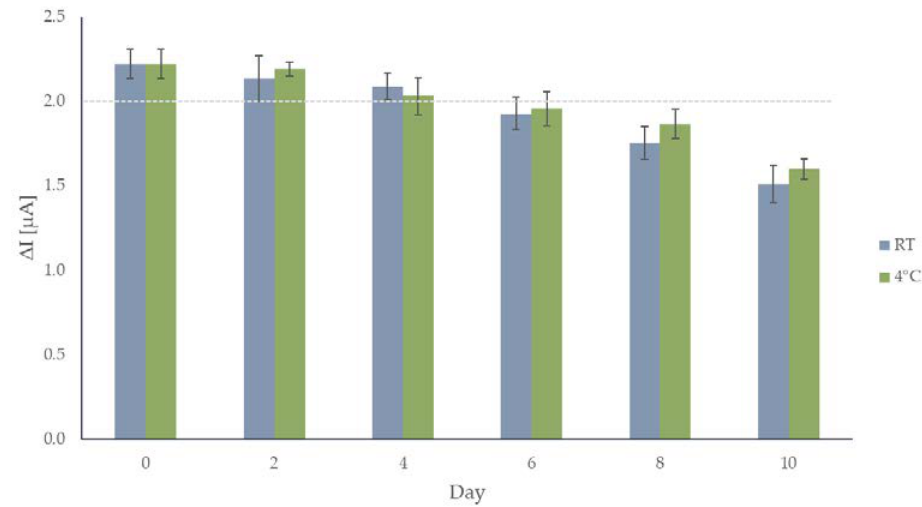
Figure 5. Average current responses to 0.2 mM glucose for the sensor after 0, 2, 4, 6, 8, and 10 days for the electrodes kept at room temperature and in the refrigerator. The dashed line is set at 90% of sensor’s initial response (1.998 µA).